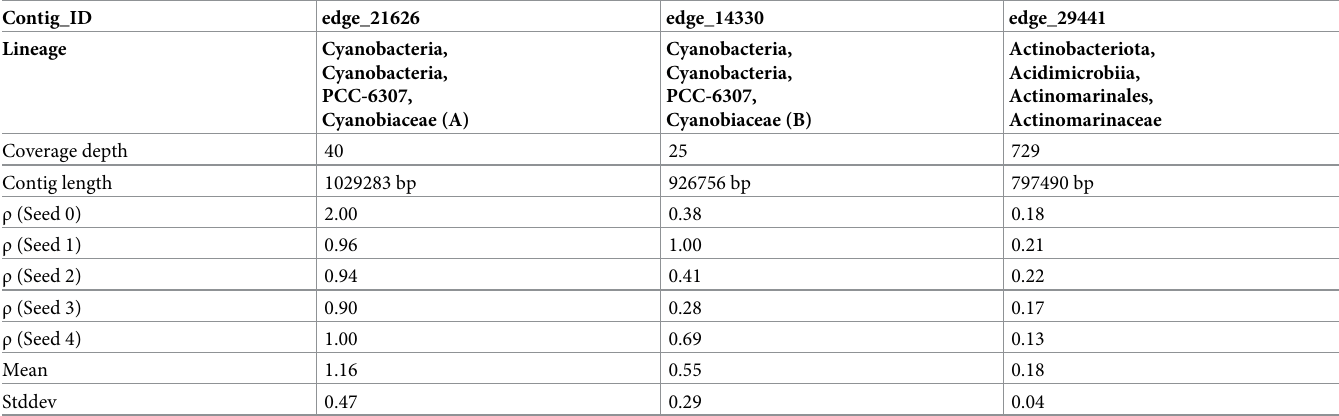
Table 3. Port Hacking